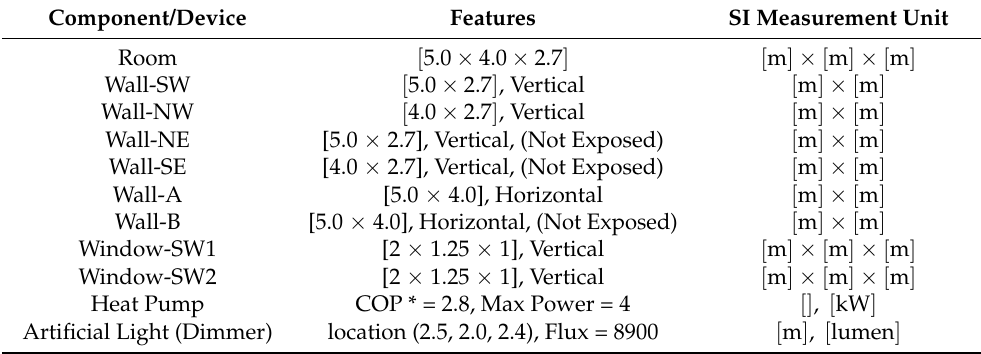
Figure 3. Overall system scheme. Table 3. Room parameters.